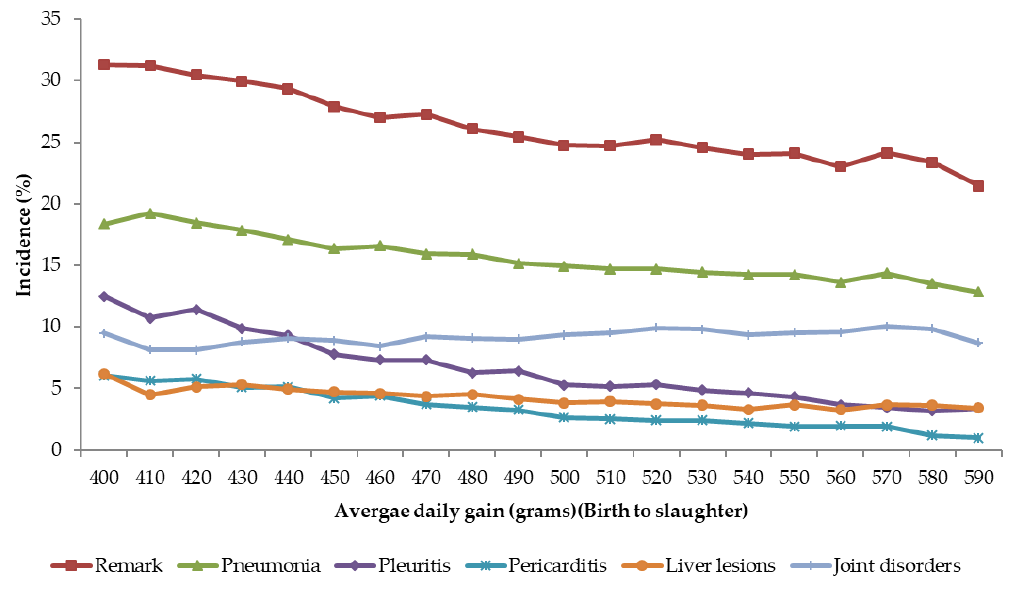
Figure 2. Relationship between growth and incidences (%) of different remarks.